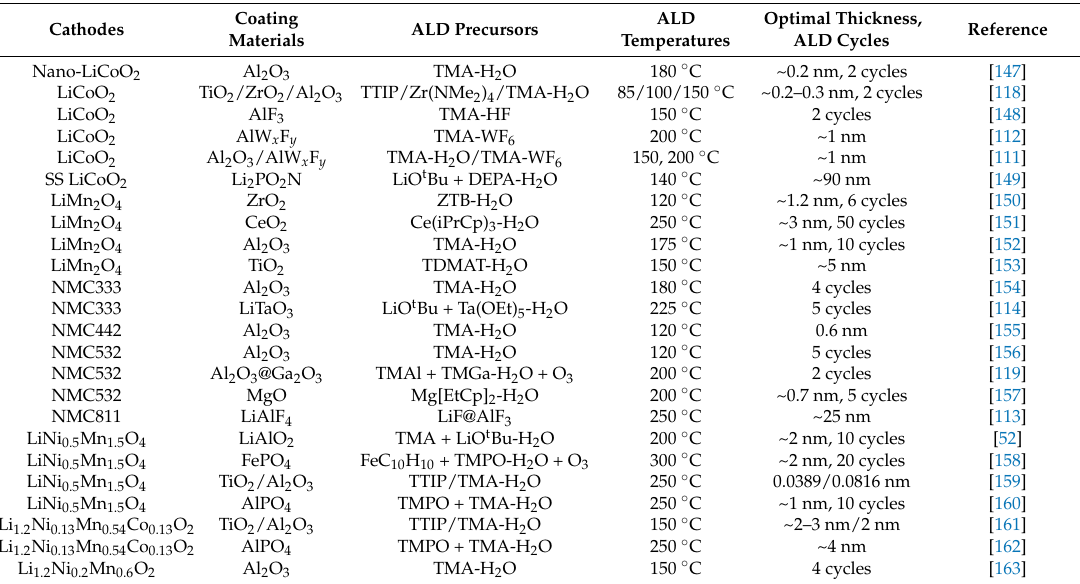
Table 3. Summary of ALD surface coatings on the